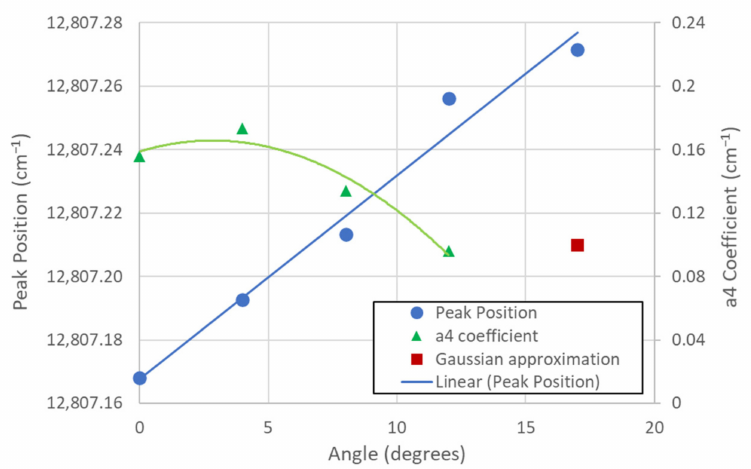
Figure 10. Measured position of peak Doppler profile for DTL28-H-H, from center to edge of grid. The a4 coefficient is a measure of width, obtained from fitting profiles with Equation